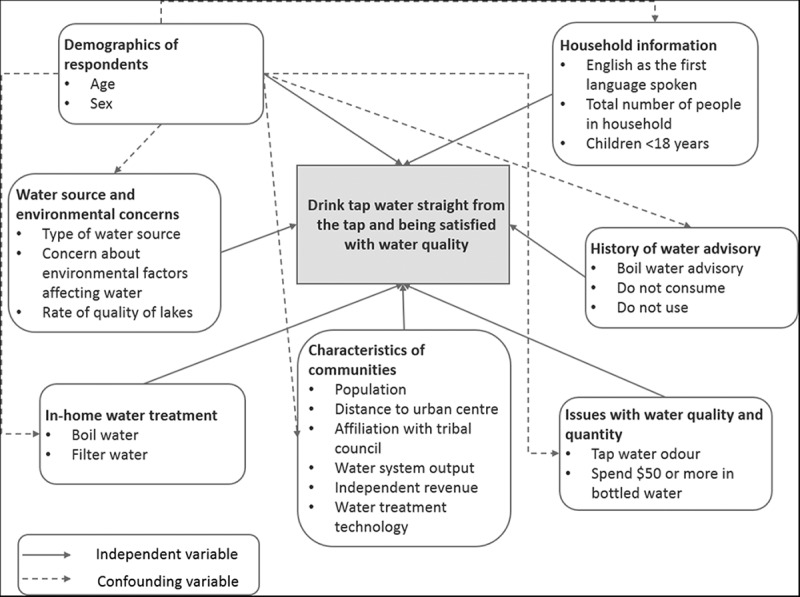
Causal diagram depicting the hypothesised relationships among potential risk factors.